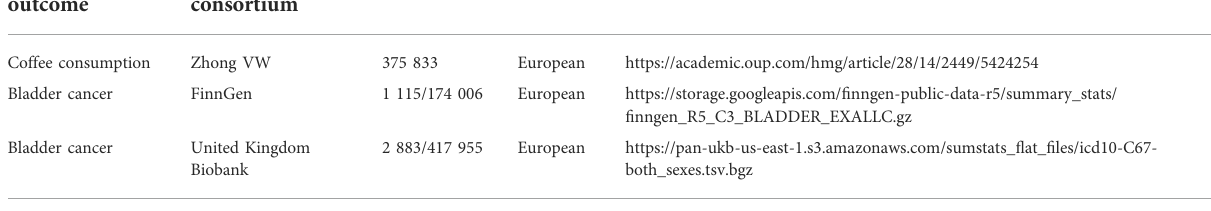
TABLE 2 Details of studies and datasets used for analyses.